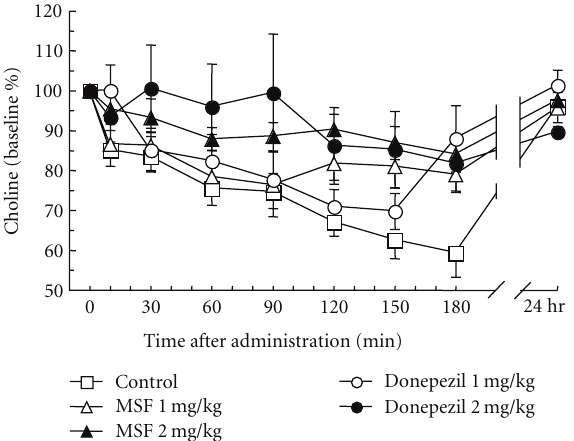
Figure 1: E ff ect of MSF and donepezil on the level of extracellular ACh in the freely moving rats. Data are expressed as percentage changes from baseline. Each value represents the mean ± S.E.M. of five experiments. Asterisks indicate e ff ects significantly di ff erent from time course vehicle control ( ∗ P < 0 . 05, ∗∗ P < 0 . 01).